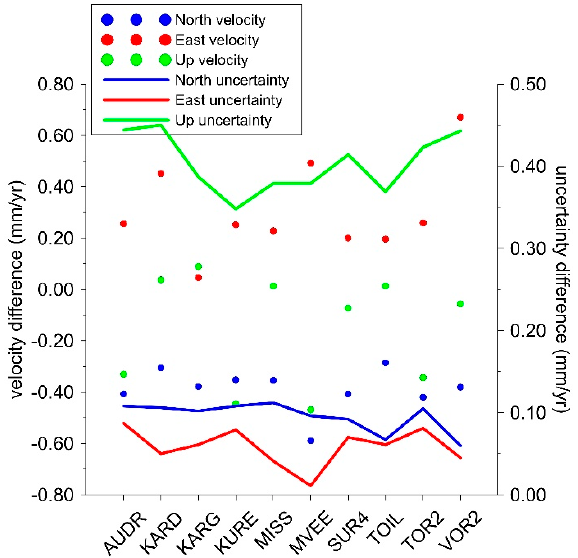
Figure 14. Differences between velocities and their uncertainties of GOA time-series’ MIDAS and BERN time-series’ MIDAS solutions.